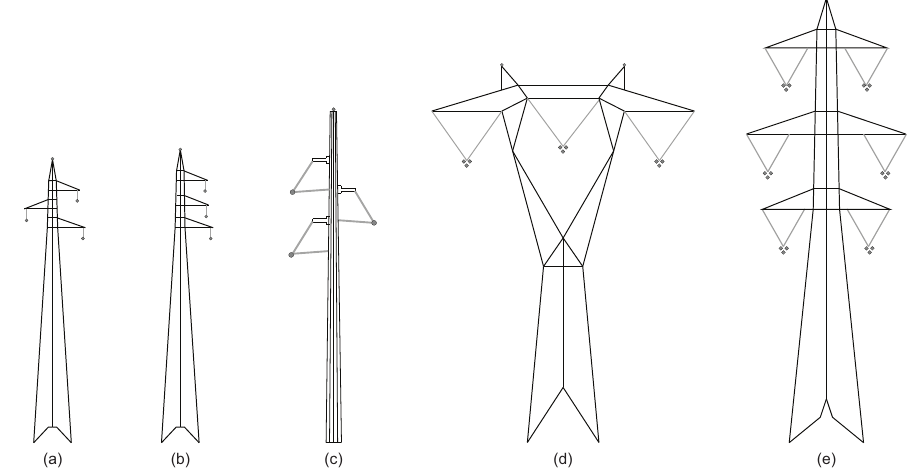
Figure 1. Typical towers for HV overhead transmission lines. ( a ) Single-circuit tower; ( b ) single-circuit tower with phase conductors located at the right-side; ( c ) tubular tower with insulating cross-arms; ( d ) cup-type tower with horizontal arrangement of the phase conductors; ( e ) double-circuit